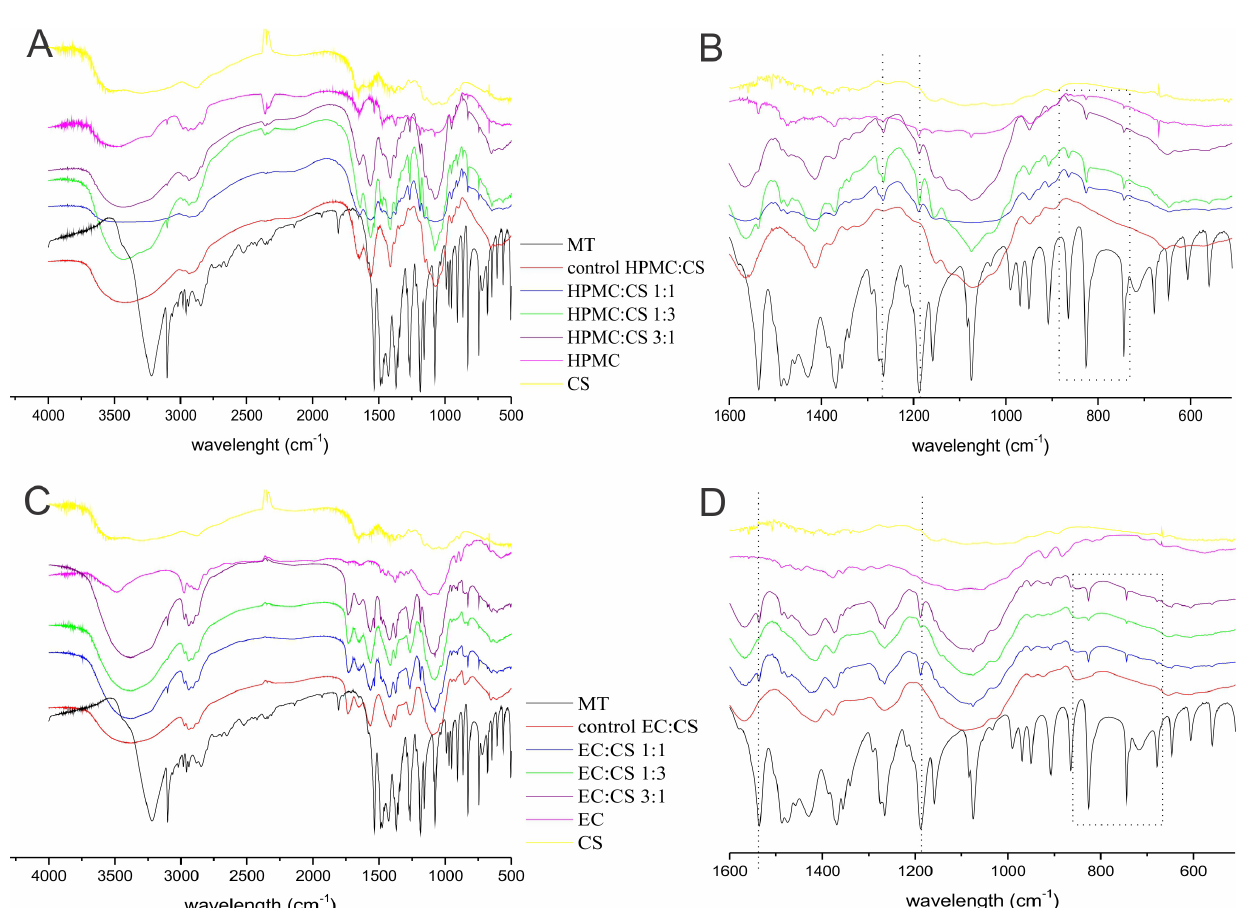
FIGURE 3 - FTIR spectrums of formulations and pure constituents: (A) HPMC and CS samples: wavelength range: 4000 cm -1 to 500 cm -1 ; (B) HPMC and CS samples: wavelength range: 1600 cm -1 to 600 cm -1 ; (C) EC and CS samples: wavelength range: 4000 cm -1 to 500 cm -1 ; (D) EC and CS samples: wavelength range: 1600 cm -1 to 600 cm -1 . MT: metronidazole; HPMC: hydroxypropyl methylcellulose; EC: ethylcellulose; CS: chitosan.